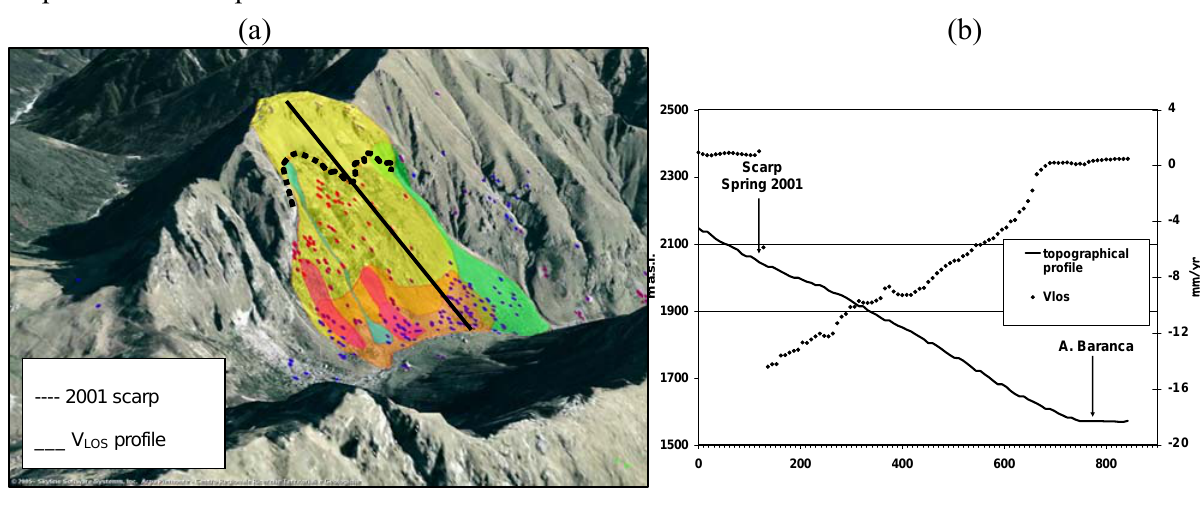
Figure 7. (a) Alpe Baranca DSGD. (b) VLOS profile along the longitudinal topographic profile in the Alpe Baranca DSGD.